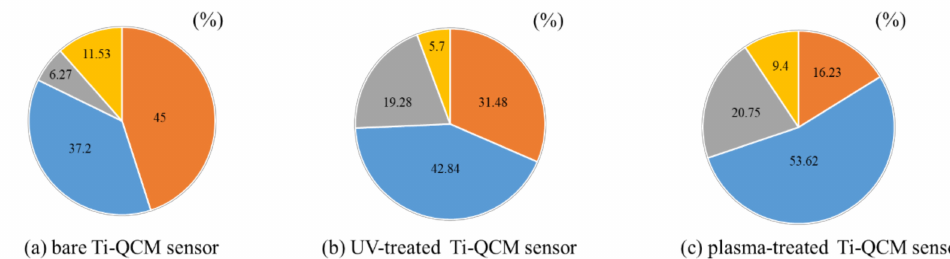
Figure 3. Results of XPS elemental analysis of ( a ) untreated, ( b ) UV-treated, and ( c ) plasma-treated Ti-QCM sensors. Orange = C1s, blue = O1s, gray = Ti2p, and yellow = other elements.